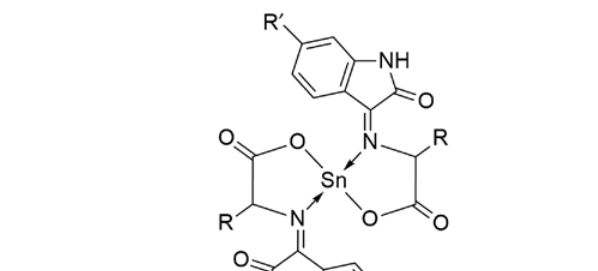
Sn(L 1 ) and Sn(L 3 ) were theoretically studied. Geometry 2 2